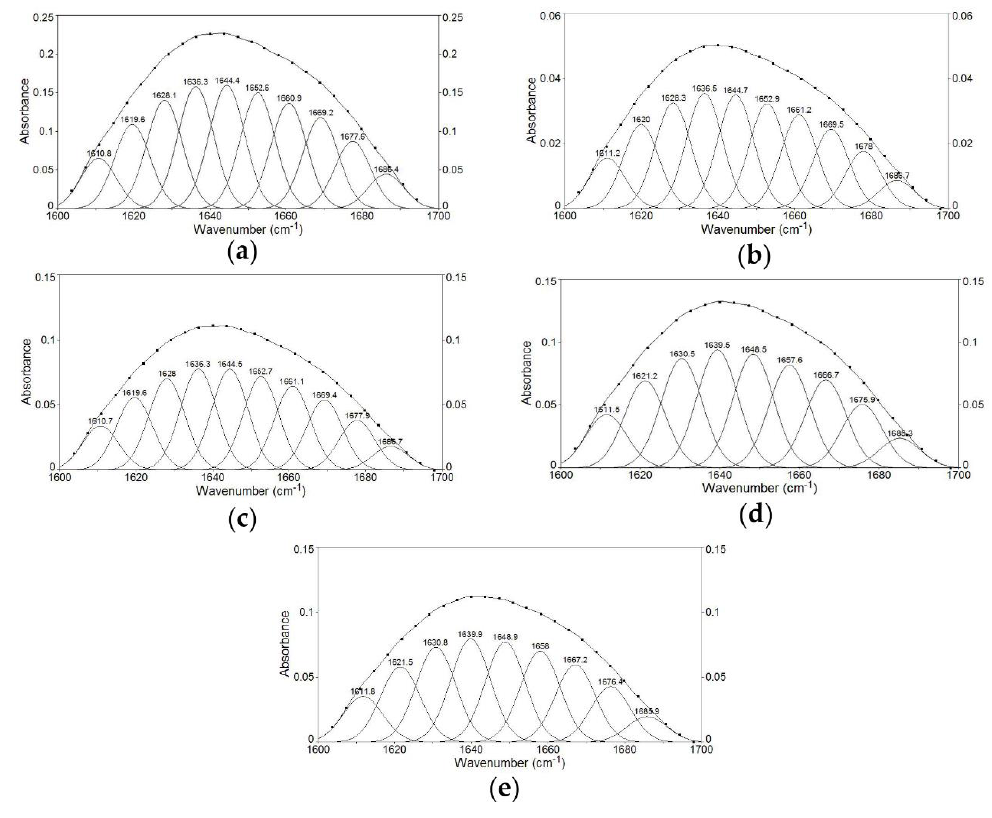
Figure 4. Second-derivative Fourier transform infrared (FTIR) spectra in the amide I region and Gaussian curve fitting of lectin at ( a ) room temperature, ( b ) 70 °C, ( c ) 80 °C, ( d ) 90 °C, and ( e ) 100 °C. Table 5. The content of the secondary structure of lectin at di ff erent